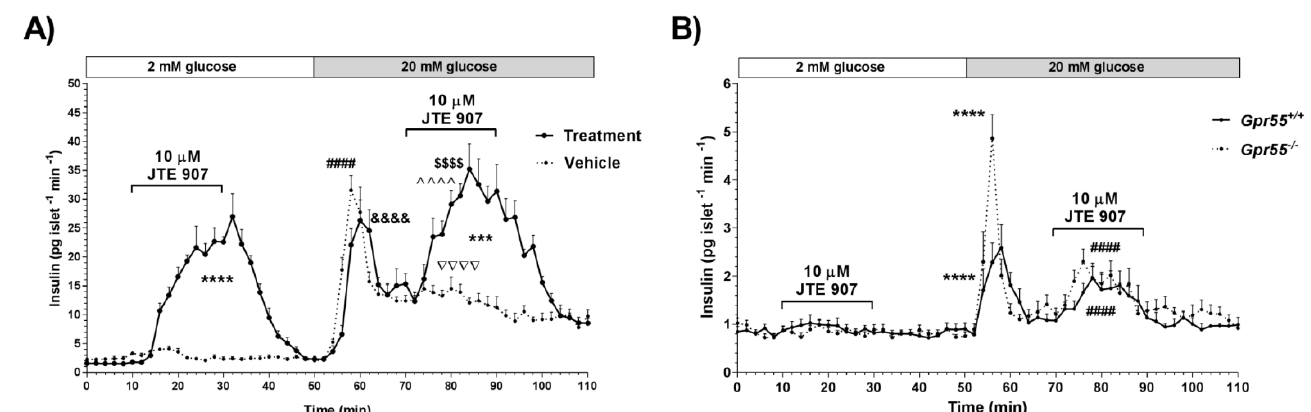
Figure 1. Effects of JTE 907 on dynamic insulin secretion from human and mouse islets. ( A ) Human islets: 10 µ M JTE 907 significantly stimulated insulin secretion from human islets at 2 mM and 20 mM glucose compared to vehicle-treated islets shown by the dotted line. Data are expressed as mean + SEM of 4 replicates within an individual experiment, representative of 3 separate experiments, 55 islets per perifusion chamber; **** p < 0.0001 and *** p < 0.001 vs. vehicle; &&&& p < 0.0001 vs. min 0–10 treatment; ^^^^ p < 0.0001 min 70–90 vs. min 50–70 treatment; $$$$ p < 0.0001 min 70–90 vs. min 0–10